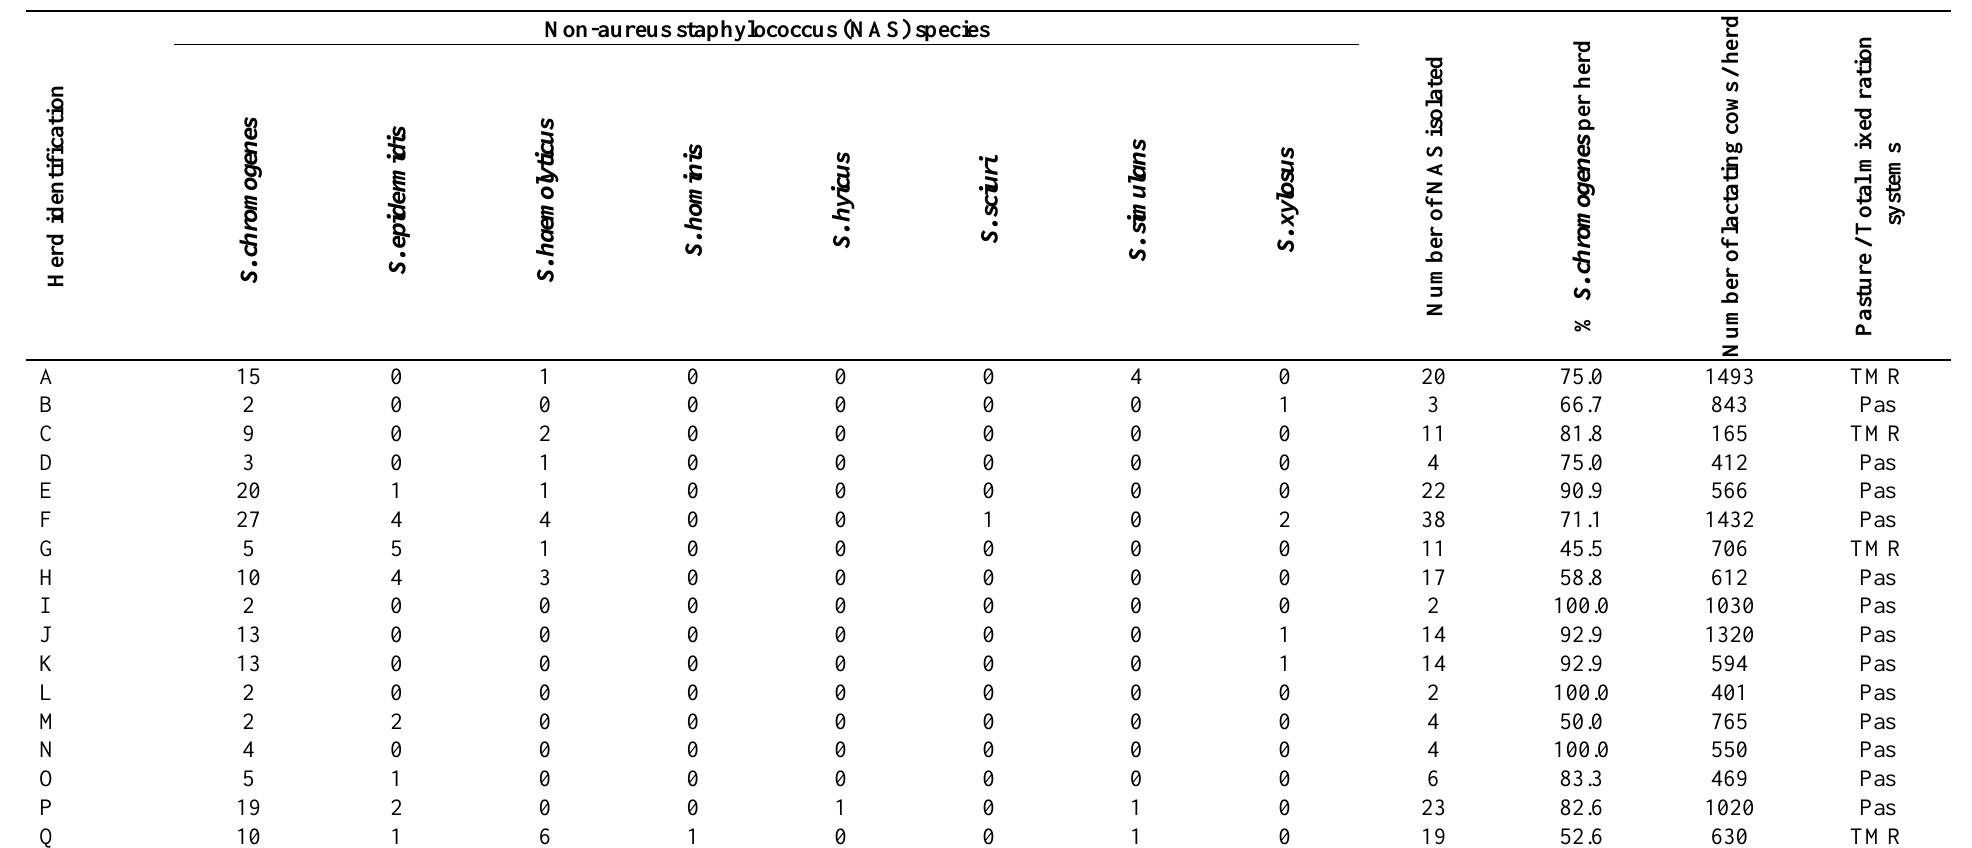
Table S3. Inter-herd relation and species variation of non-aureus staphylococci species isolated from milk samples of 17 dairy herds with different farming systems and herd